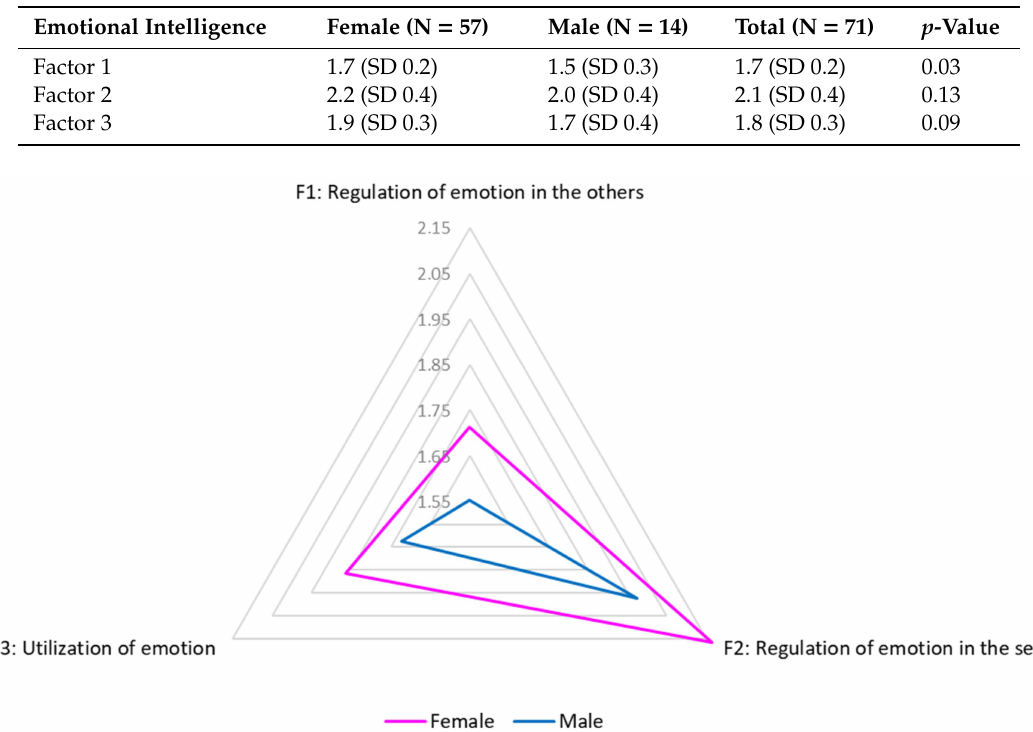
Table 5. Mean, standard deviation and p -value (Student’s t -test) of sample’s EI factors score, stratified by gender.